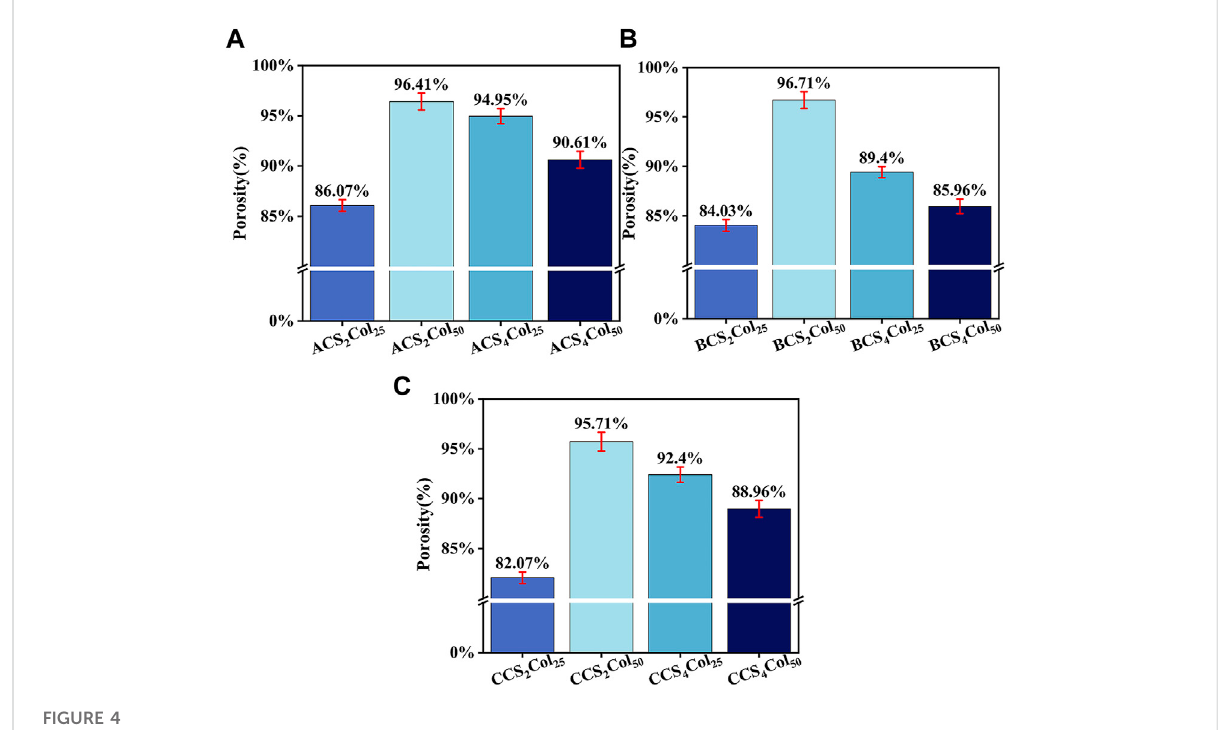
FIGURE 4 Porosity results of the scaffolds, ACSCols (A) , BCSCols (B) , and CCSCols (C)